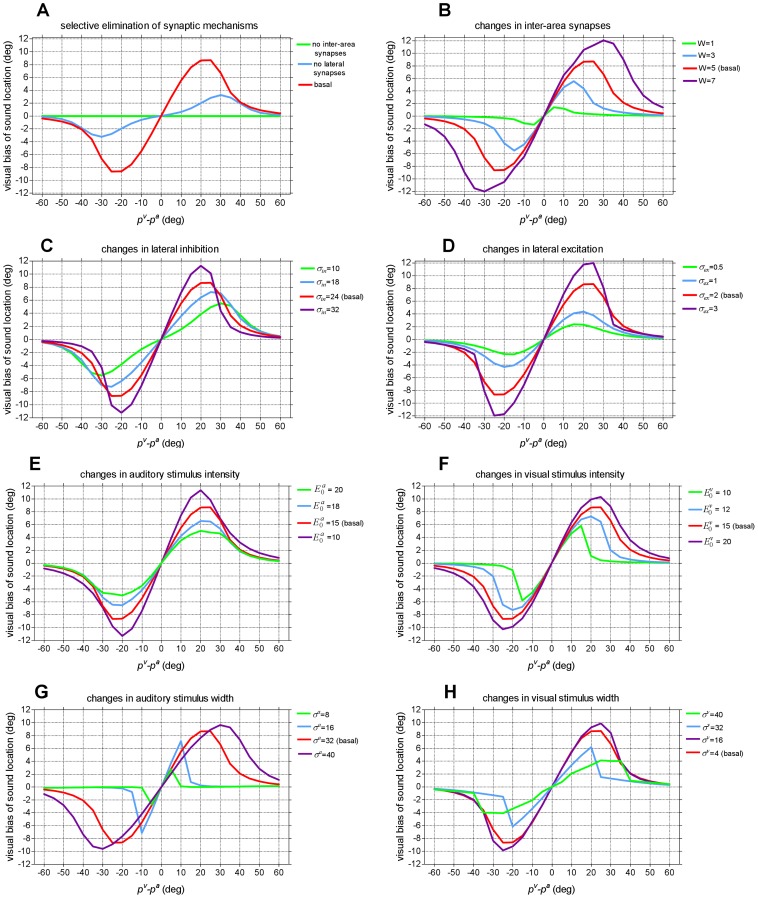

Results of sensitivity analysis.Visual bias of sound location as a function of the visual-auditory angular separation (same simulation as Fig. 4), obtained using different values for the parameters characterizing synaptic connections (panels A, B, C, D) and external stimuli (panels E, F, G, H). One parameter at a time was changed, by maintaining the others at their basal value. (A) Selective elimination of synaptic mechanisms (elimination of inter-area synapses, elimination of lateral synapses). (B) Changes in the weight of inter-area connections (W). (C) Changes in the extension of lateral inhibitory synapses (σin). (D) Changes in the extension of lateral excitatory synapses (σex). It is worth noting that here the balance between lateral excitation and inhibition was varied by modifying the width of lateral synapses. Similar results can be obtained by acting on the strength of lateral synapses (parameters Lex0, Lin0). (E) Changes in the strength of the auditory stimulus (). (F) Changes in the strength of the visual stimulus (). (G) Changes in the width of the auditory stimulus (σa). (H) Changes in the width of the visual stimulus (σv).